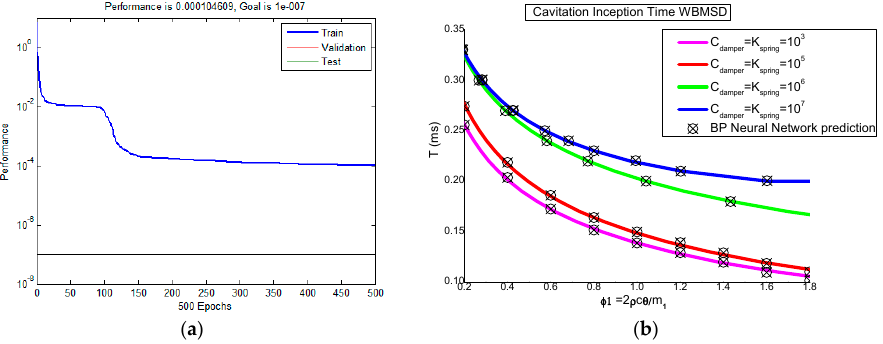
Figure 8. Training process performance curve ( a ) and comparison of the BP neural network prediction with the analytical results ( b ).